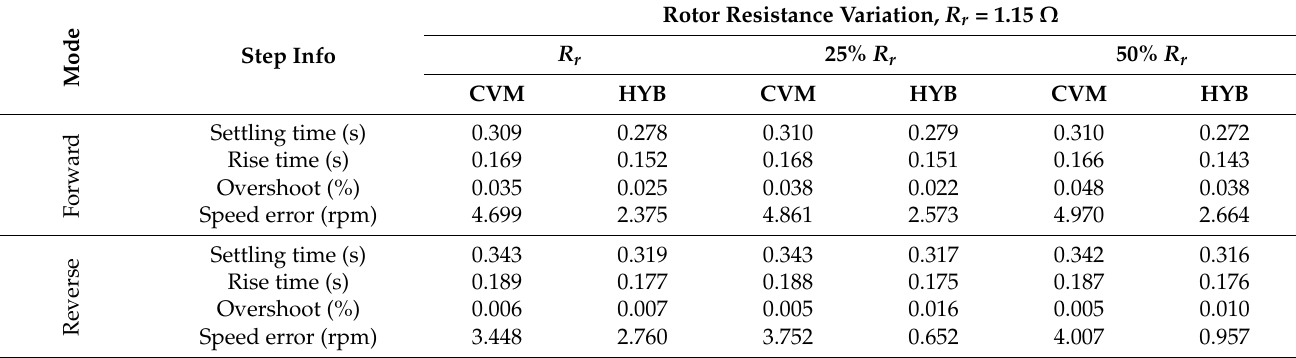
Figure 11. Rotor speed response against rotor resistance variation: ( a ) in forward operation and ( b ) in reverse operation. Table 1. Rotor speed performance under rotor resistance variation.